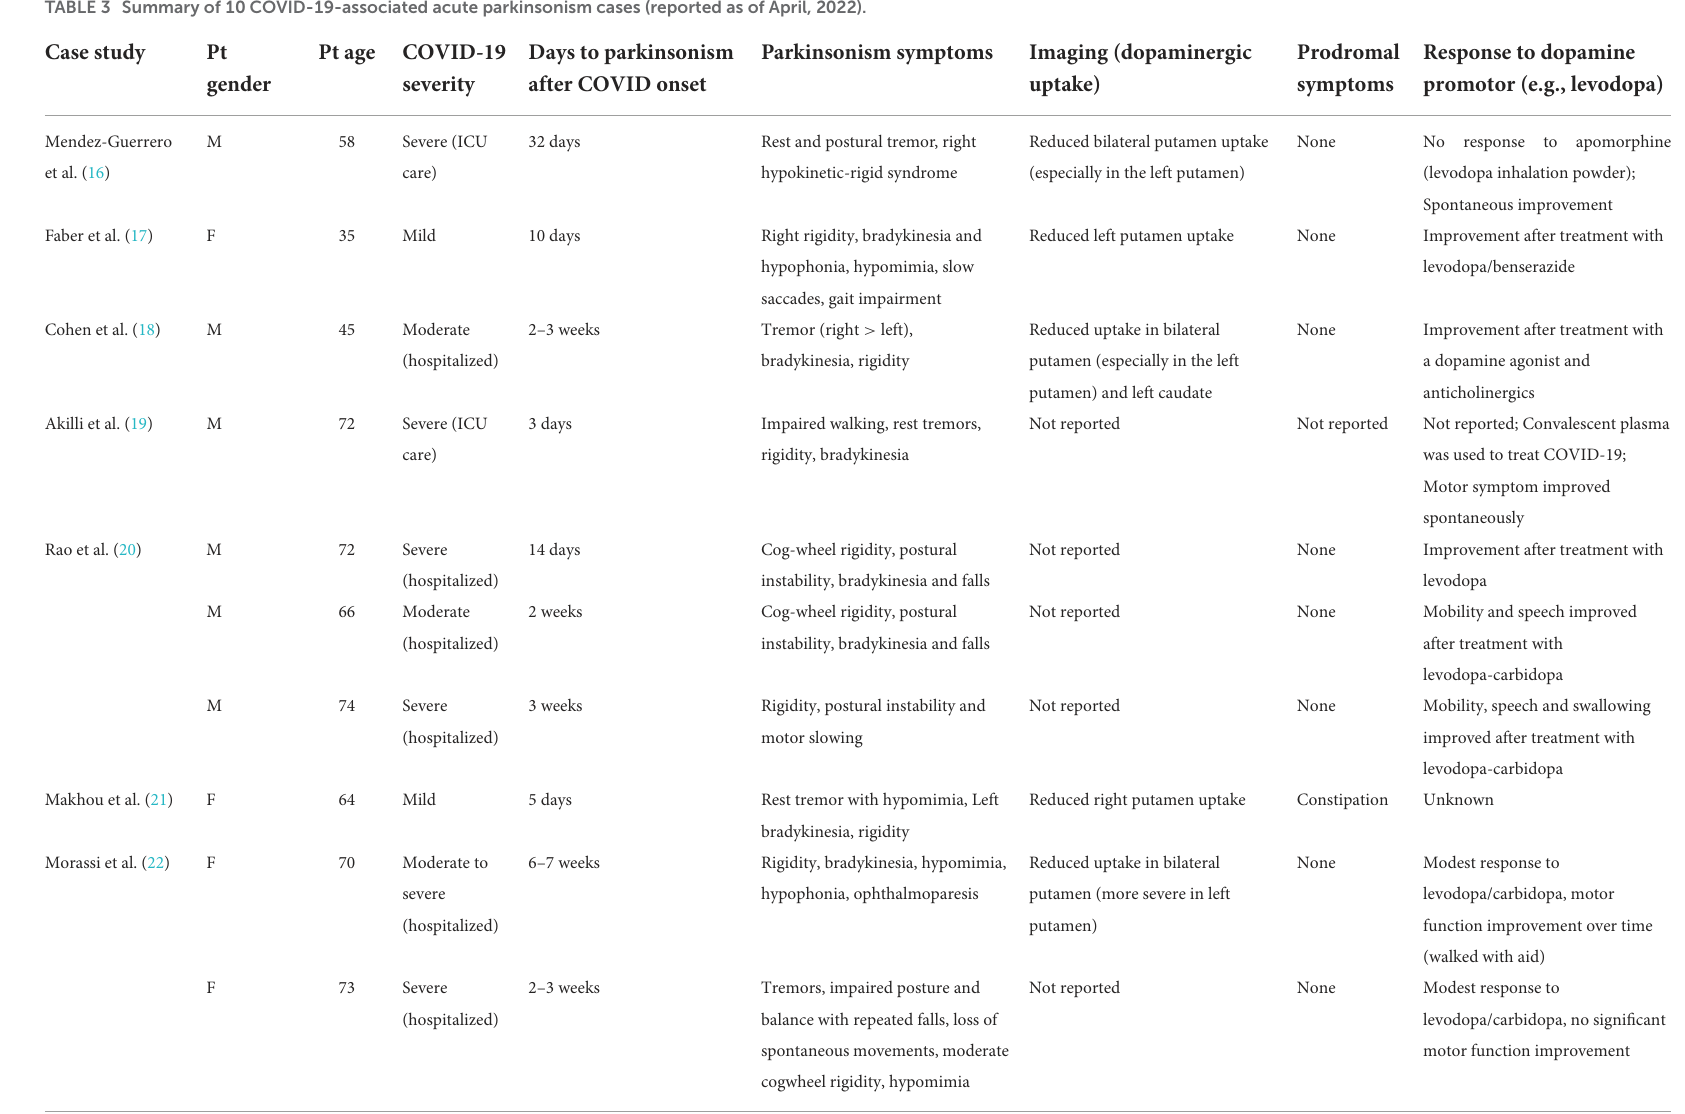
TABLE 3 Summary of 10 COVID-19-associated acute parkinsonism cases (reported as of April, 2022). Case